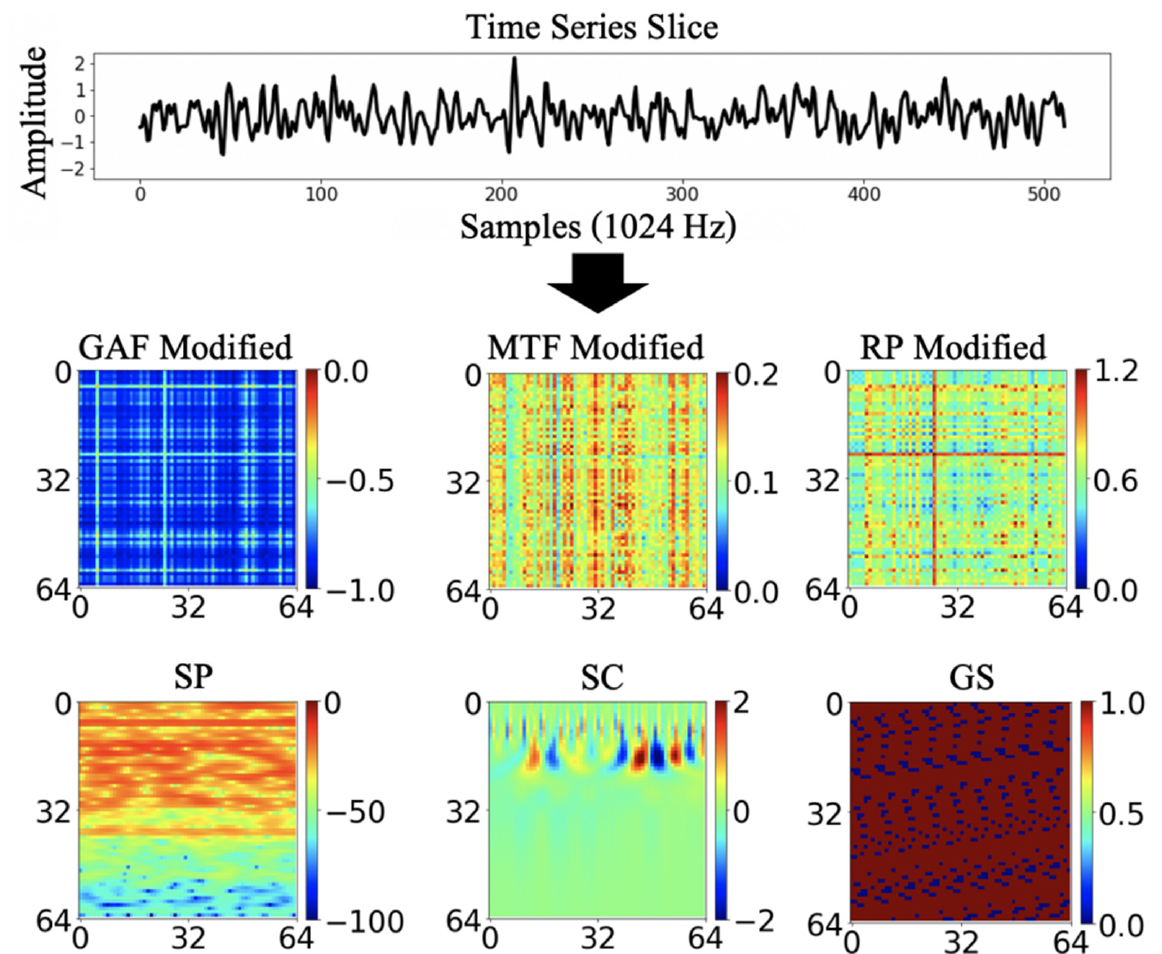
Figure 1. Comparison of relative transformation schemes from the same sample of RSSI data in [24]; results of GAF on the left, MTF in the center, and RP on the right.